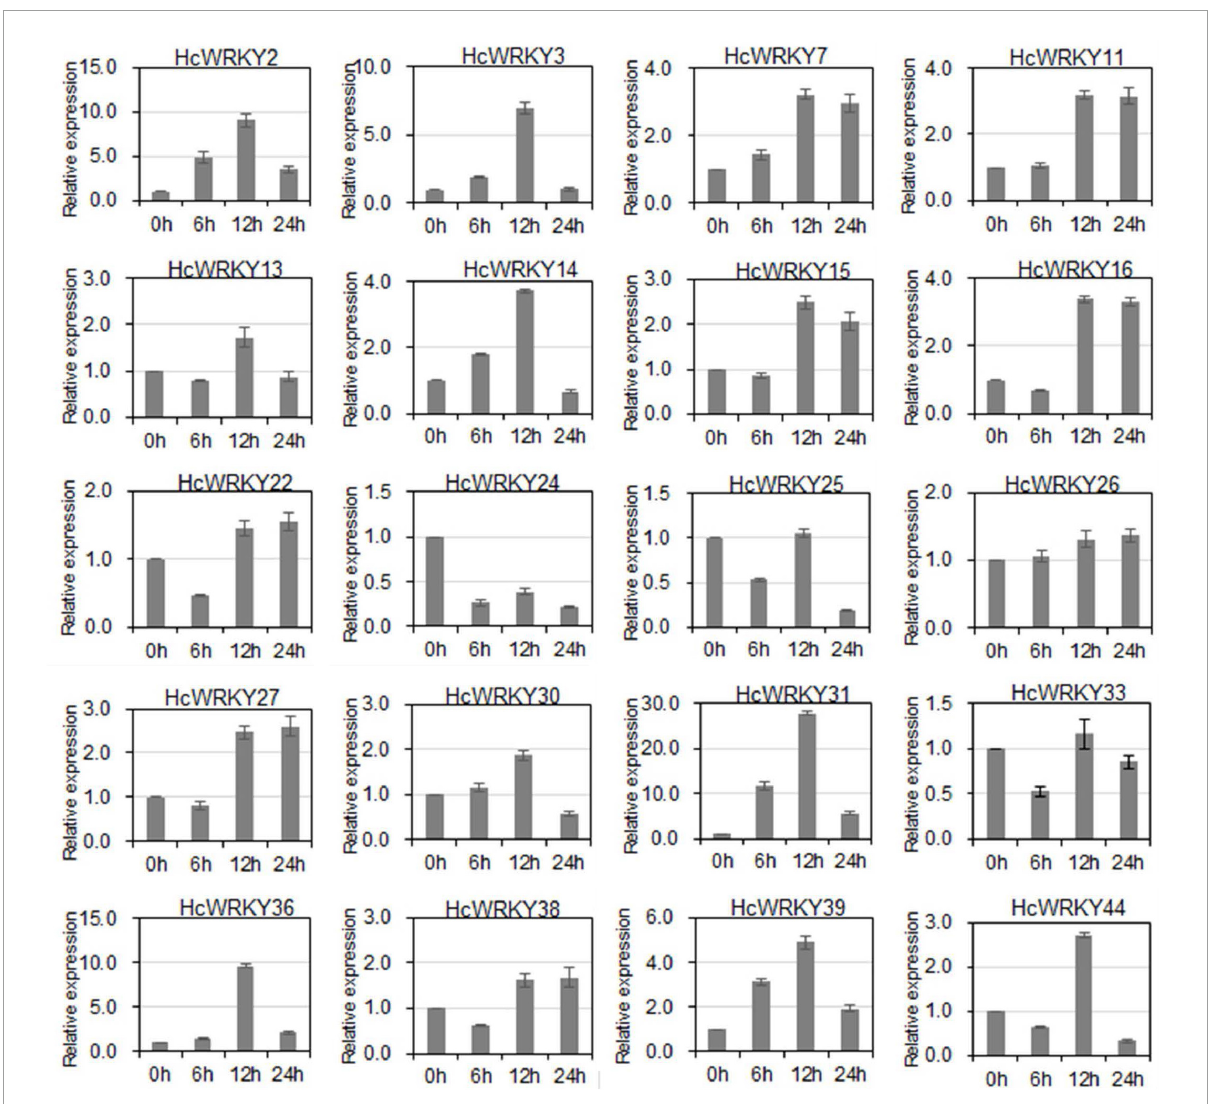
FIGURE4 Expression profiles of 20 HcWRKY genes under NaCl stress. Twenty HcWRKY genes were cloned and selected for expression analysis under salinity stress, mimicked by 200 mM NaCl solution irrigation. After treatment, leaves were harvested and used for mRNA transcripts analysis by qRT-PCR. The 18S rRNA and TUB α gene was used as the standard control to normalize the qRT-PCR results. Each assay was replicated three